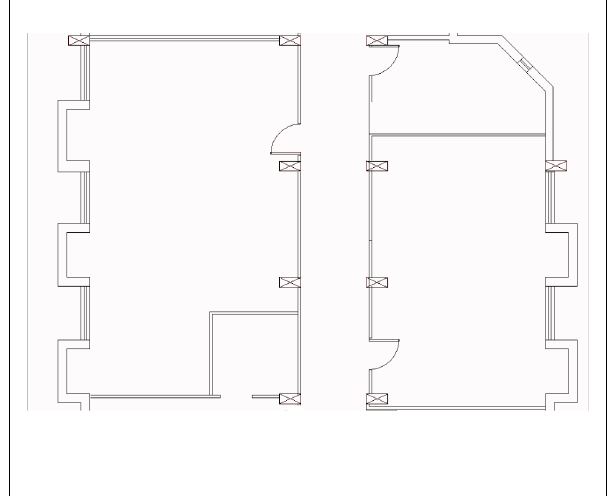
Figure 1: Part of floor-plan showing a set of rooms and a corridor